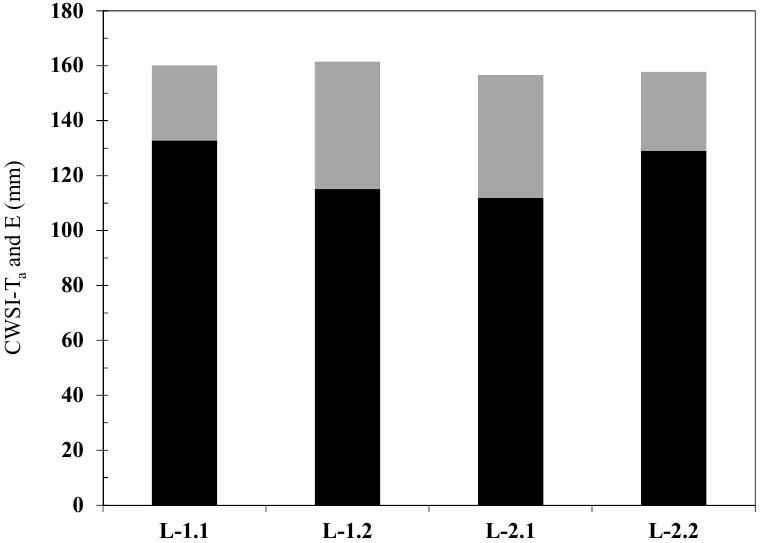
Figure 7. Total CWSI-T (black bars) and average water evaporation from the soil a surface (E) (gray bars) during the study period and averaged over all four hours